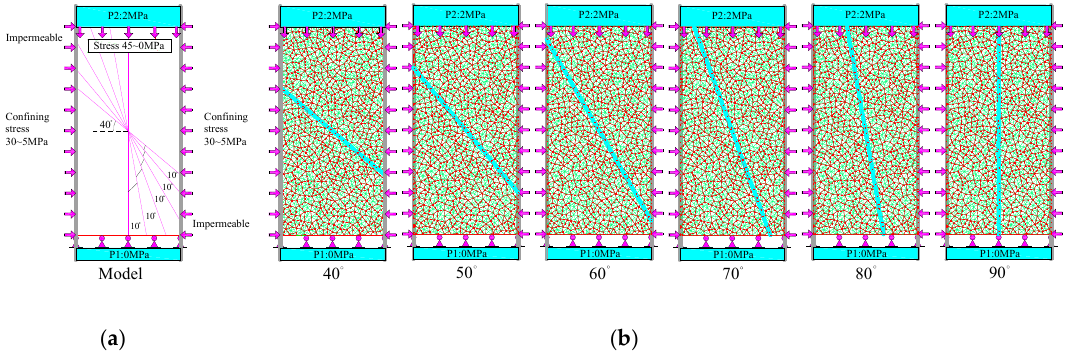
Figure 11. Single crack model with different angles: ( a ) design scheme and ( b ) calculation model.